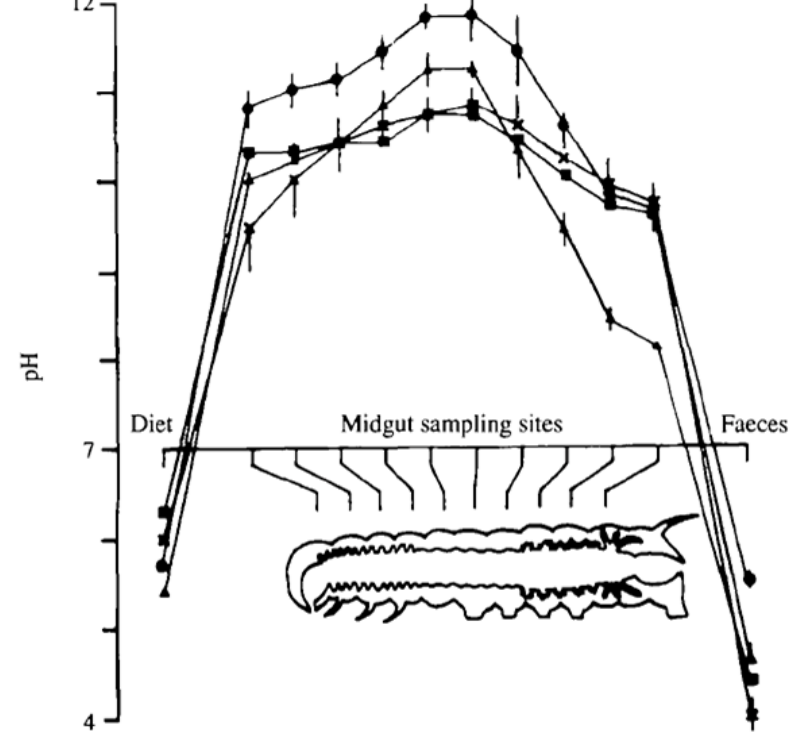
Figure 4. pH profile of the midgut of Lepidopteran larvae. The midgut is highly alkaline along the entire path of the midgut and it is in this environment that the virus infects new cells to propagate the infection. Reproduced with permission from Dow, J.